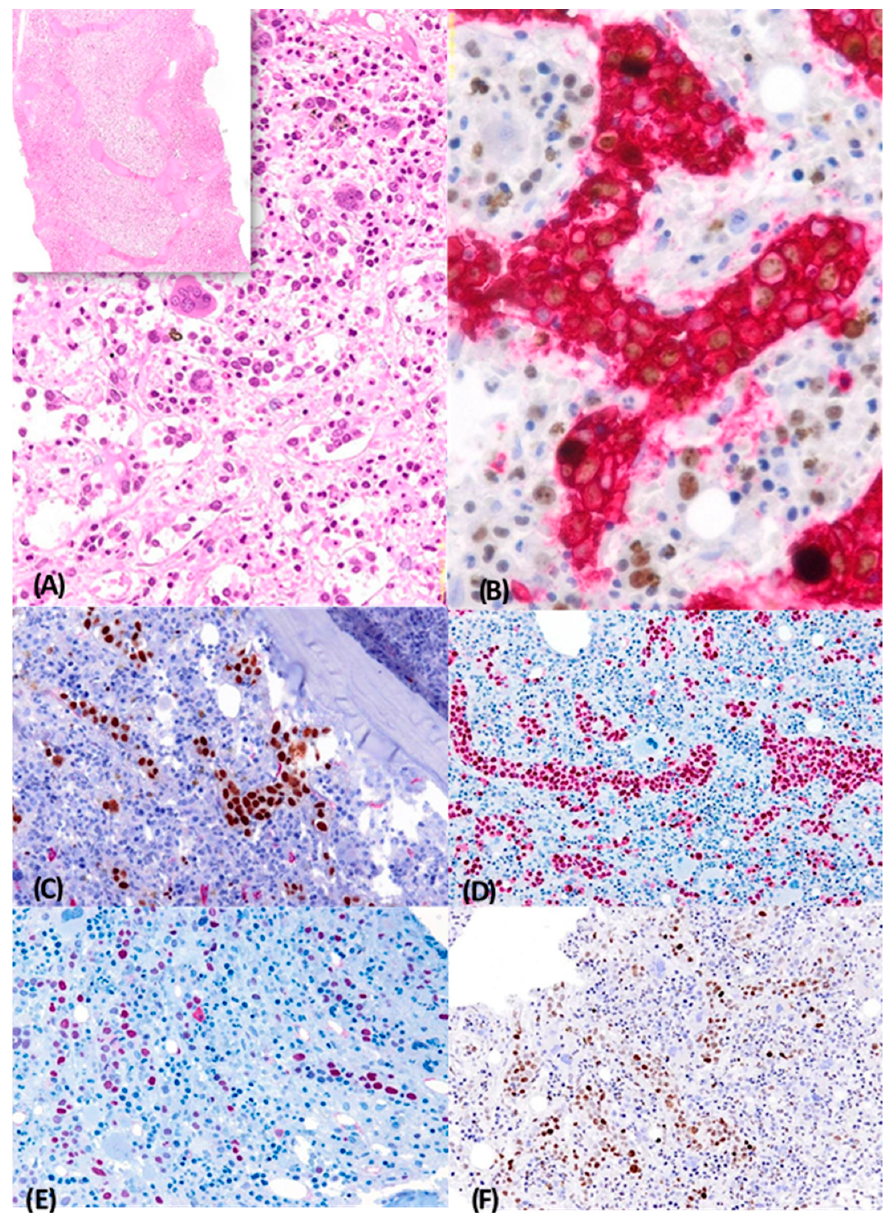
Figure 1. ( A ) H&E: the bone marrow biopsy showed high cellularity (inset; × 5), and at higher power magnification features of granulopoetic delayed maturation (MDS-like) and abnormal megakaryocytes were observed, as well as the presence of large, atypical cells within the vessel lumen ( × 20). ( B ) CD20/Ki67: the double staining for CD20 and Ki67 showed that the intrasinusoidal pleomorphic cells co-expressed CD20 and Ki67 ( × 40). ( C ) PAX5/CD34: the double staining highlighted that the PAX5-positive neoplastic cells were engulfed within blood vessels that were also stained focally positive for CD34 ( × 20). ( D ) IRF4: intense nuclear staining for MUM1/IRF4 antigen in the neoplastic cells; confirmation of the purely intravascular infiltration of the neoplastic cells is also provided by this image ( × 20). ( E ) c-Myc: nuclear staining for c-Myc protein in most neoplastic cells at moderate to strong intensity ( × 20). ( F ) Bcl6: nuclear staining for Bcl6 antigen at moderate to strong intensity ( × 20); confirmation of the purely intravascular infiltration of the neoplastic cells is also provided by this image ( ×